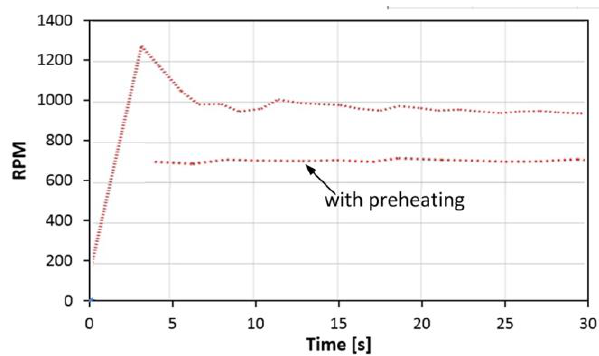
Fig. 7. Engine crankshaft speed at idle after starting with and without preheat system at –14 o C